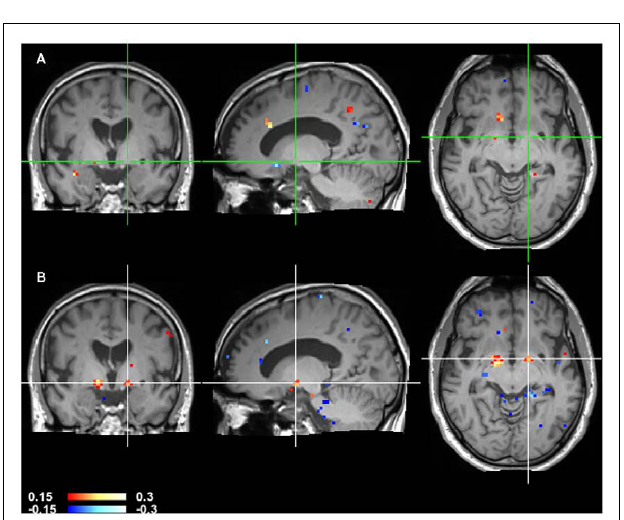
FIGURE 7 | CCM dynamics in a stroke patient. CCMs of consecutive time points of Figure 6 were subtracted to highlight changes over time.The top image (A) shows CCM(t1, t2) minus CCM(t2, t3).The bottom image (B) shows CCM(t2, t3) minus CCM(t3, t4). Note that globus pallidus marked by the crosshair shows a large difference in the second difference image but not in the first indicating that the changes in this area occur at a late stage.